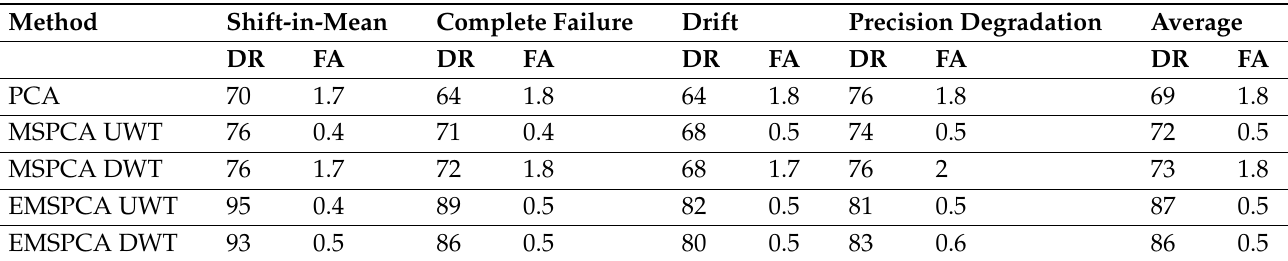
Table 3. CSTR Sensor Fault Detection MC Simulation